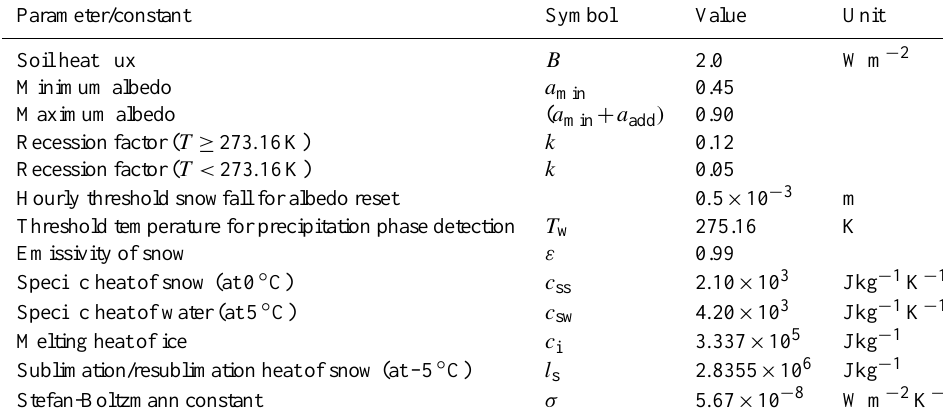
Table 1. Parameter values and constants used in ESCIMO.spread . Parameter/constant Symbol Value Unit Soil heat flux B 2.0 Wm − 2 Minimum albedo a min 0.45 Maximum albedo ( a min + a add ) 0.90 Recession factor ( T ≥ 273 . 16K) k 0.12 Recession factor ( T < 273 . 16K) k 0.05 Hourly threshold snowfall for albedo reset 0 . 5 × 10 − 3 m Threshold temperature for precipitation phase detection T w 275.16 K Emissivity of snow ε 0.99 Specific heat of snow (at 0 ◦ C) c ss 2 . 10 × 10 3 Jkg − 1 K − 1 Specific heat of water (at 5 ◦ C) c sw 4 . 20 × 10 3 Jkg − 1 K − 1 Melting heat of ice c i 3 . 337 × 10 5 Jkg − 1 Sublimation/resublimation heat of snow (at –5 ◦ C) l s 2 . 8355 × 10 6 Jkg − 1 Stefan-Boltzmann constant σ 5 . 67 × 10 − 8 Wm − 2 K −